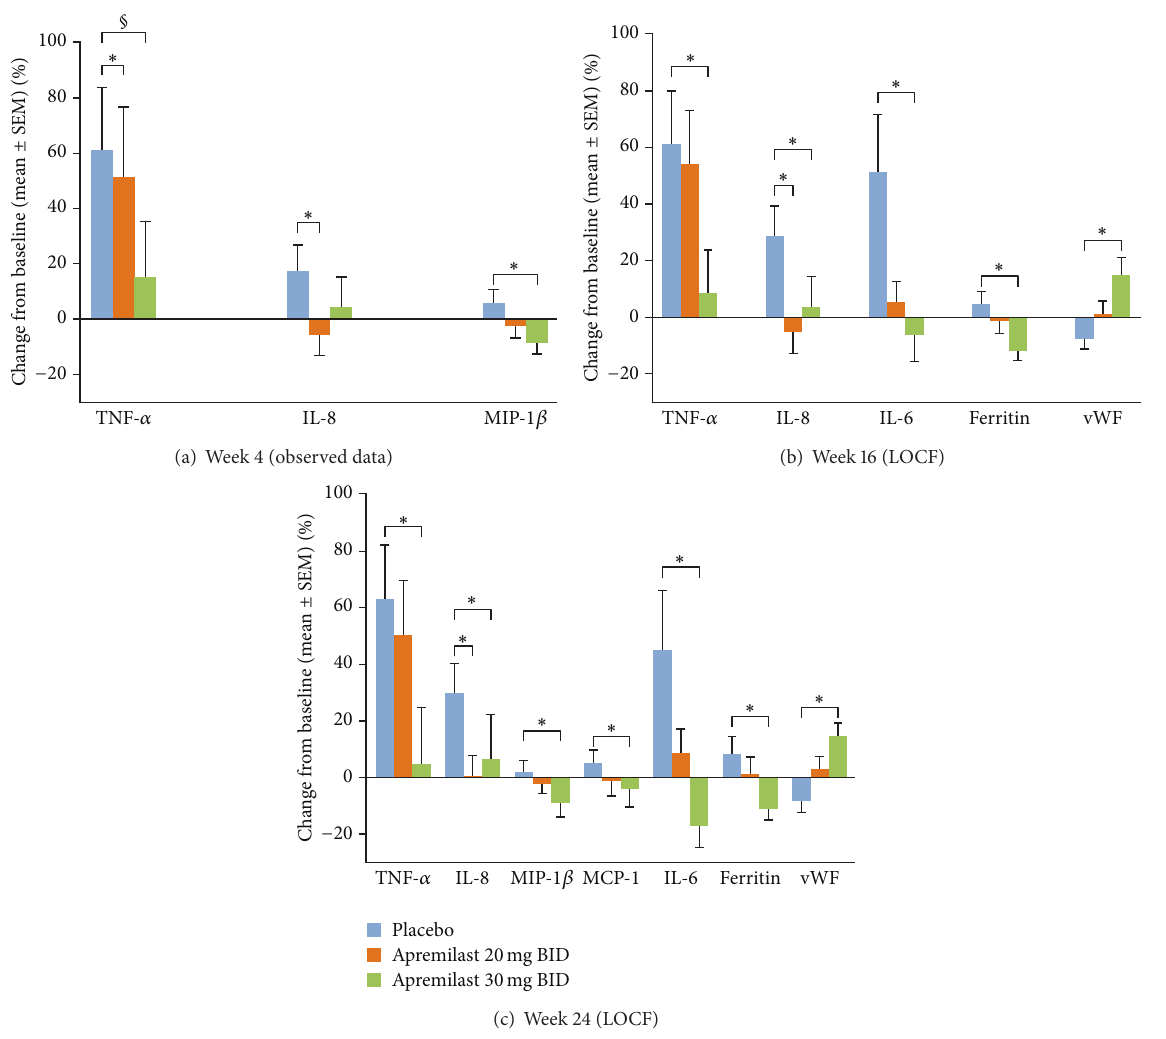
Figure 2: Changes in biomarkers with placebo, apremilast 20 mg BID, and apremilast 30 mg BID over Weeks 0 to 24. ∗ 𝑃 < 0.05 versus placebo (rank analysis of covariance two-sided 𝑃 value). § 𝑃 = 0.0527 . SEM: standard error